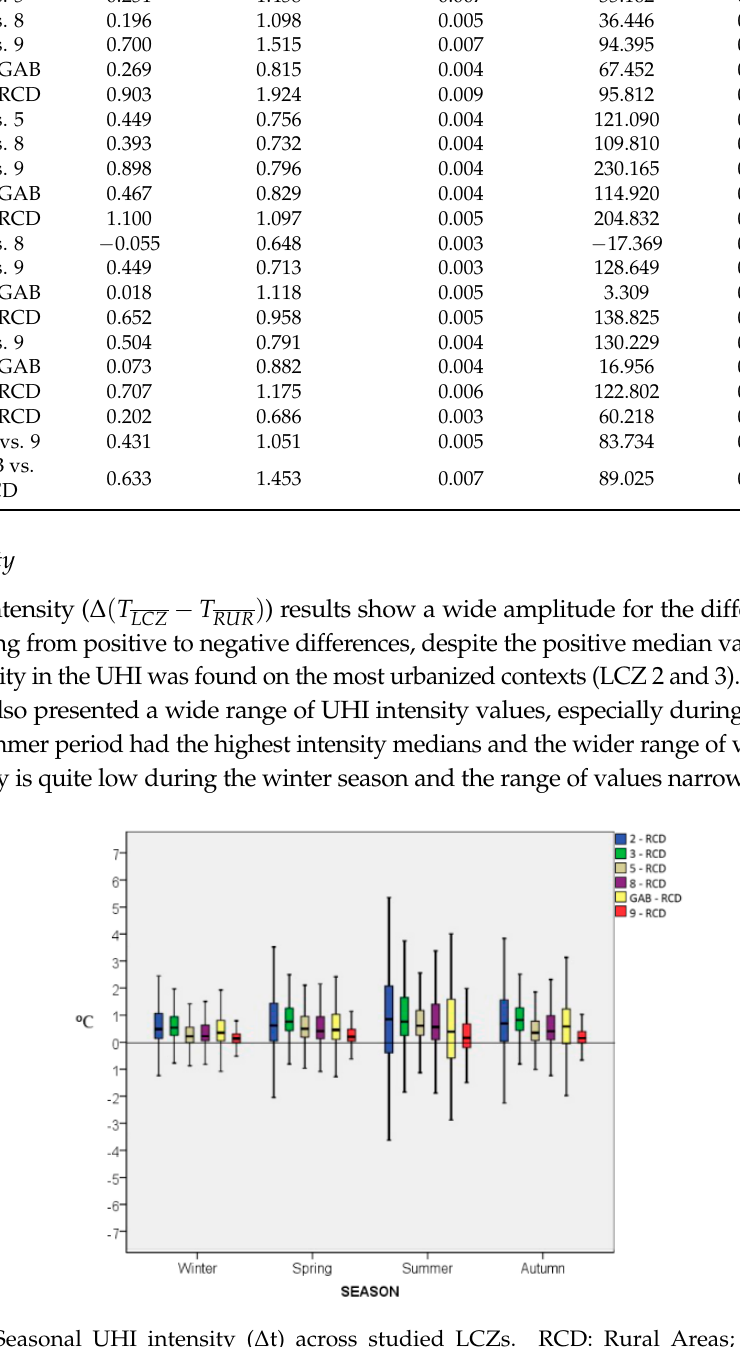
Table 3. Paired samples t -test results for the average temperature in the different LCZs.